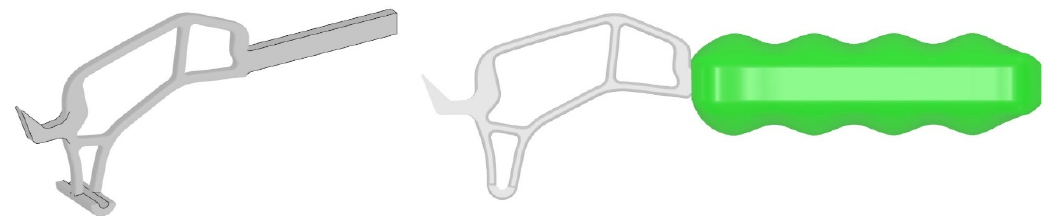
Figure 12. Final models of structural head and assistive device.